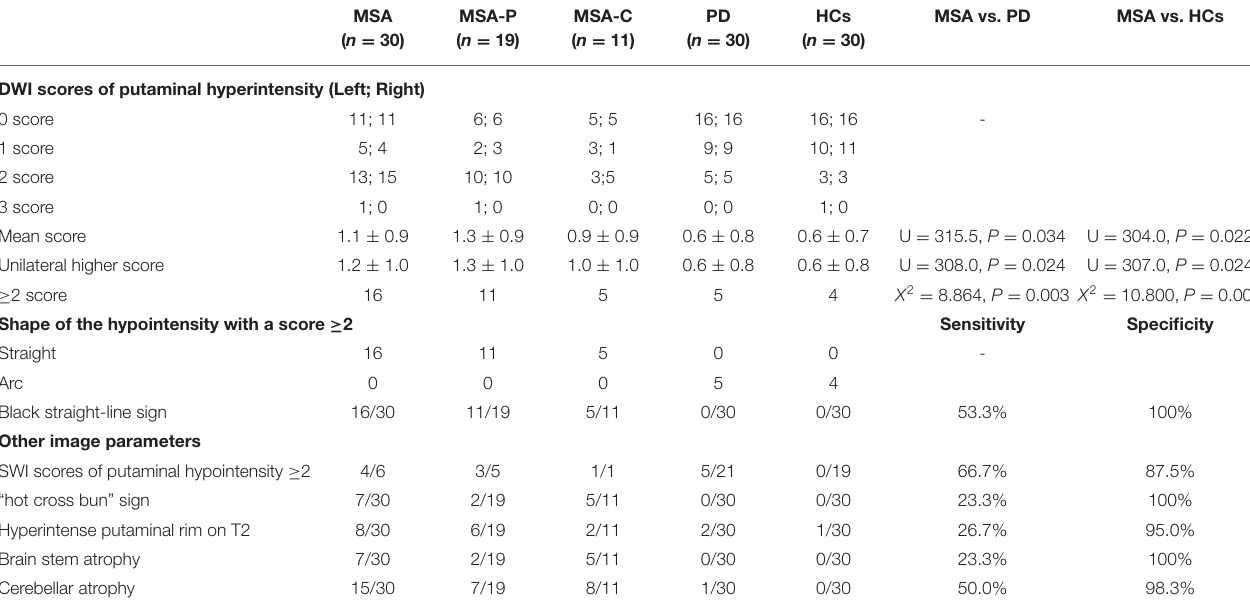
TABLE 2 | DWI scores of putaminal hypointensity and other image